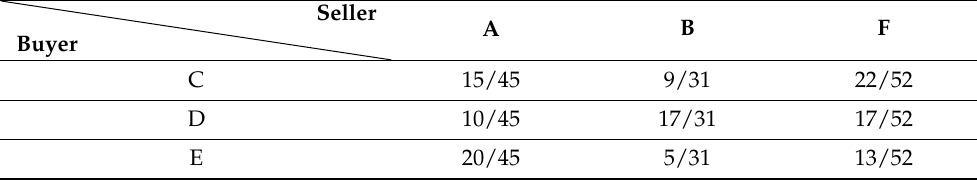
Figure 2 . Example network for the proposed matching process . Figure 2. Example network for the proposed matching process. Table 1. The calculation example of distance factors . Table 1. The calculation example of distance factors.